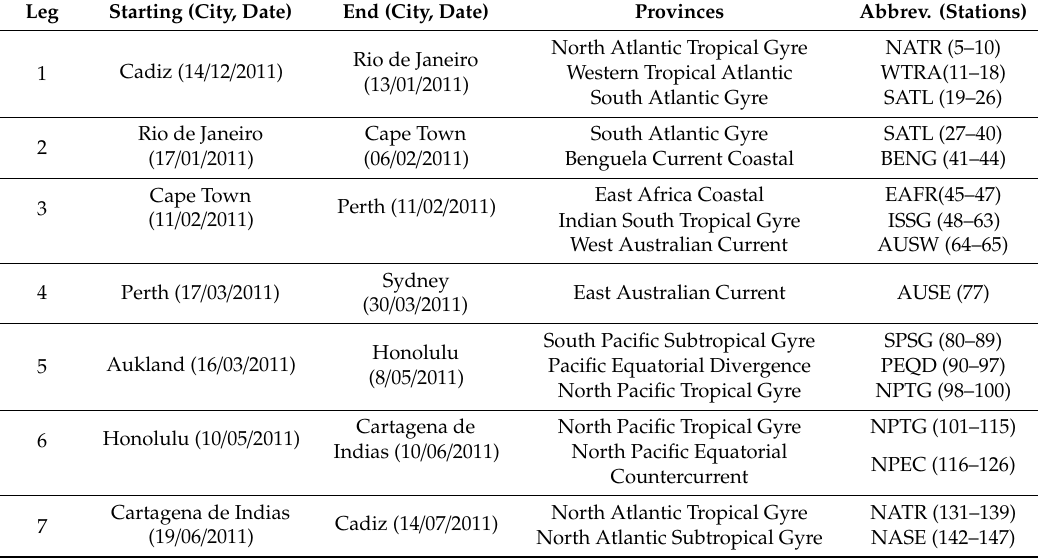
Figure 1. Stations sampled for zooplankton community analyses along the Malaspina 2010 Circumnavigation Expedition and the outline of the Longhurst provinces visited along the cruise track according to Table 1 [7]. The numbers indicate the first and last zooplankton stations samples at each leg. Table 1. Different legs, stations, and Longhurst provinces visited during the Malaspina 2010 expedition.